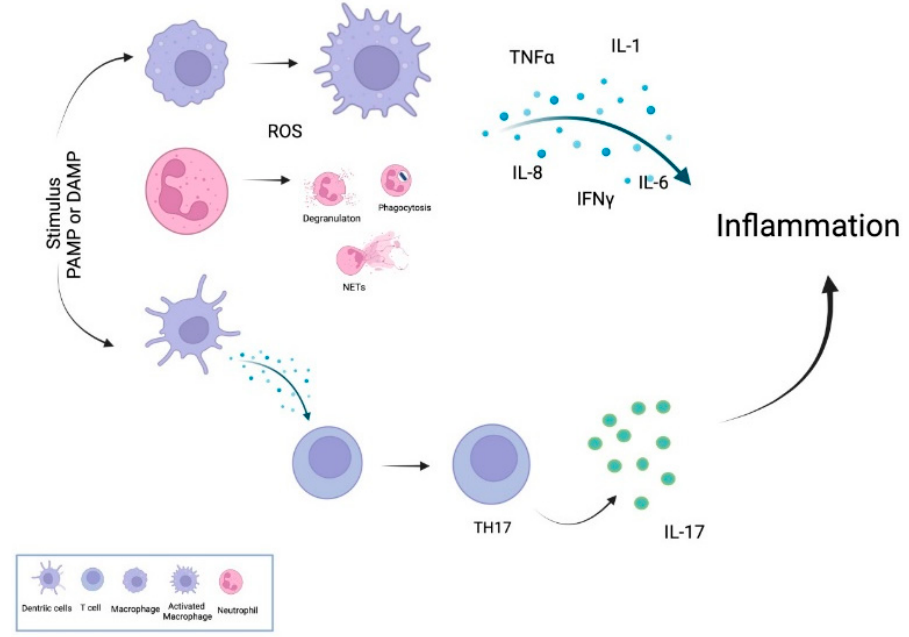
Figure 1. General mechanisms of inflammation. Innate immune cells (macrophages, dendritic cells, and neutrophils) stimulated by PAMPs or DAMPs, leading to their activation. Neutrophils display different mechanisms for eliminating pathogens. Dendritic cells are also involved in the differentiation of T cells to the TH17 phenotype. All these cells secrete different proinflammatory cytokines that promote the inflammatory process created with Bioreder.com (accessed on 28 March